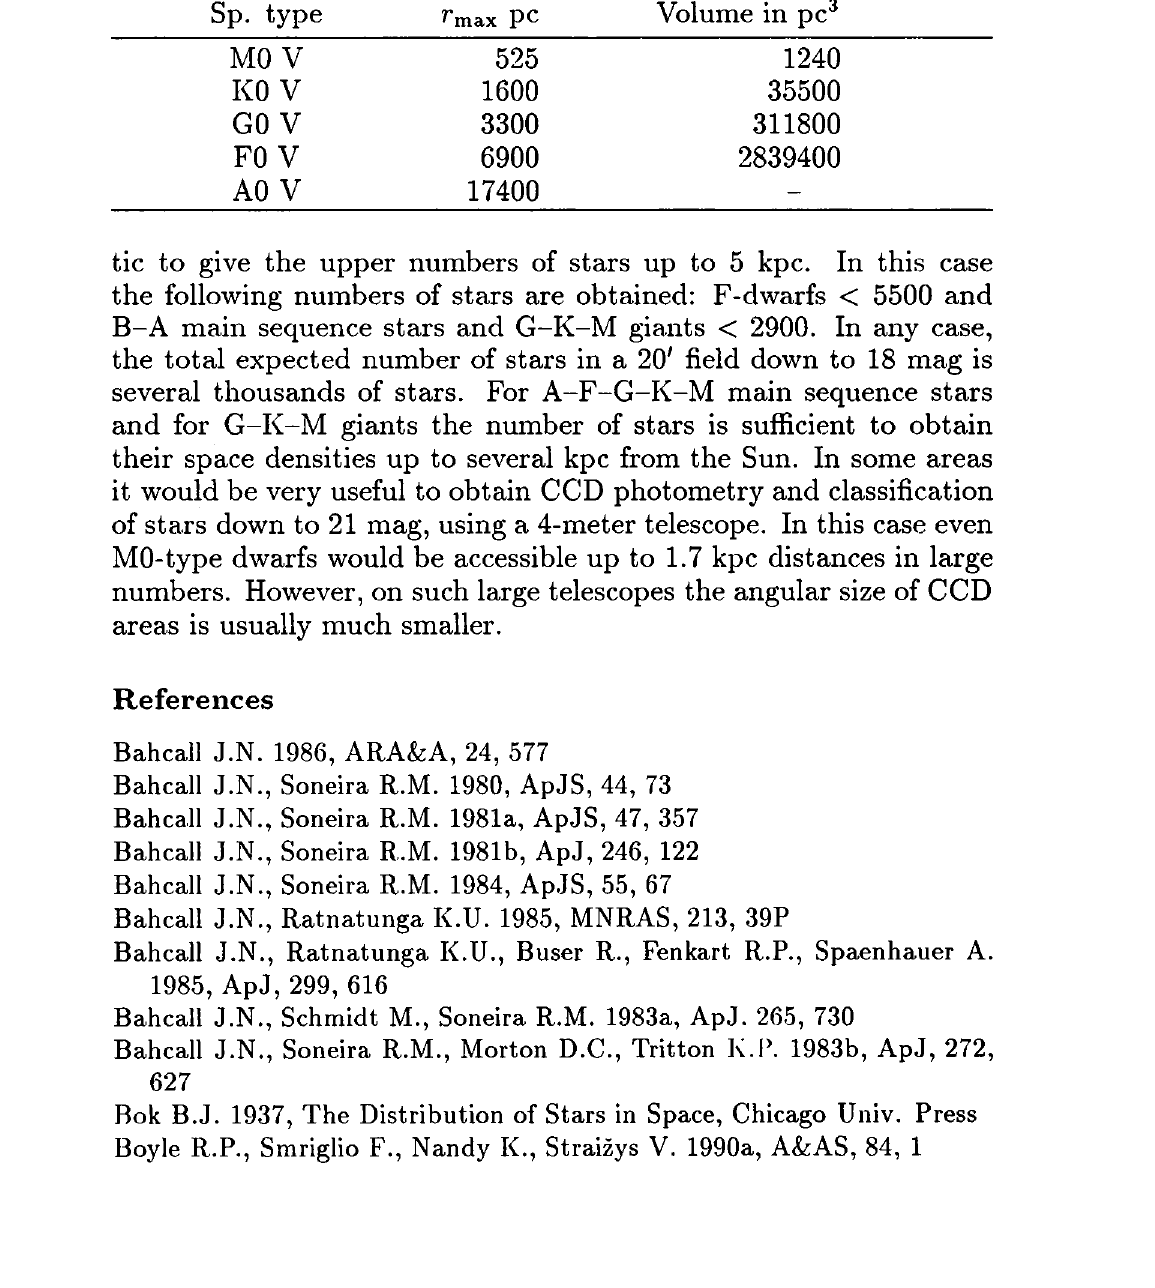
Table 3. Maximum distances of stars of some spectral types with V= 18 mag and Ay = 1.0 (for MO V stars Ay = 0.5) and volumes of space up to these distances for a 20'